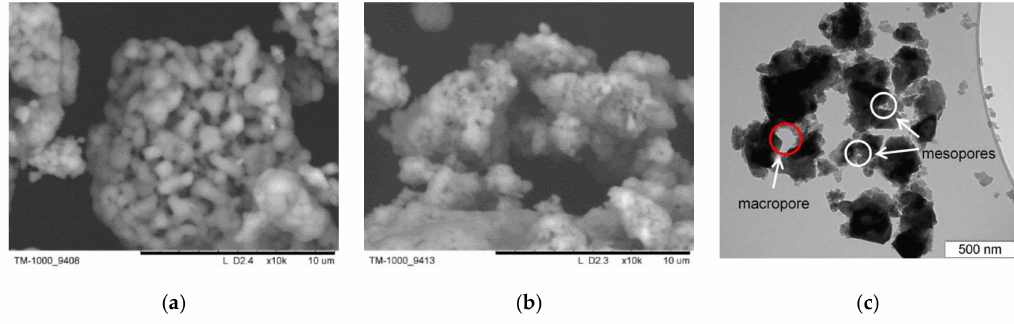
Figure 3. Scanning electron microscopy (SEM) ( a , b ) and transmission electron microscopy (TEM) ( c ) images of LFMP ( a ) and LFMP / C ( b , c ).